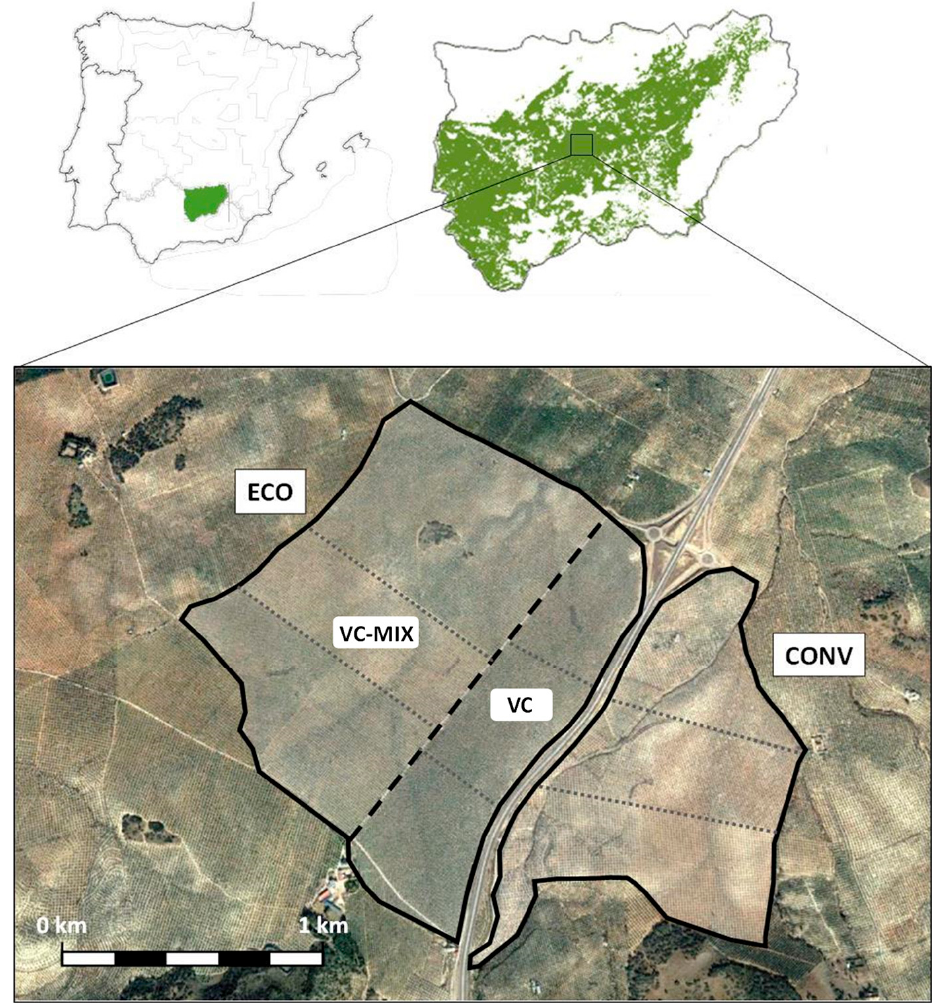
Figure 1. Location of the study area in the province of Jaén (Southern Spain). Olive grove with conventional management (CONV); olive grove with ecological management (ECO), including two large extensions: Olive grove with mixed cover (VC-MIX) and olive grove with herbaceous cover (VC). By dotted lines, the three blocks in each olive grove are delimited. Source: Own elaboration, using the Google Earth Pro geographic information system.